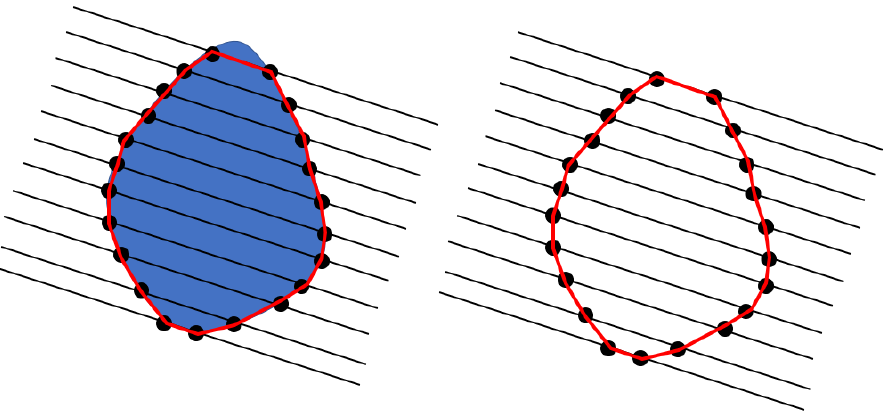
Figure 15. Schematic diagram of irregular defect. Eleven equidistant black lines are used to divide the area of irregular defect. A red broken line is extracted to replace the irregular defect profile.